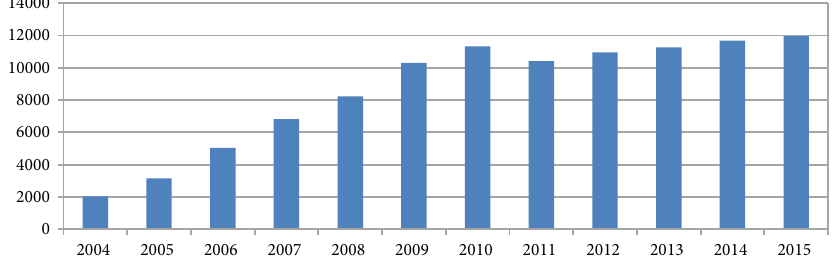
Fig. 1. Biofuel production in the EU (2004–2015) (in 1,000 metric tons of oil equivalent) Source: author’s graph based on Statista database (Economic Freedom Network